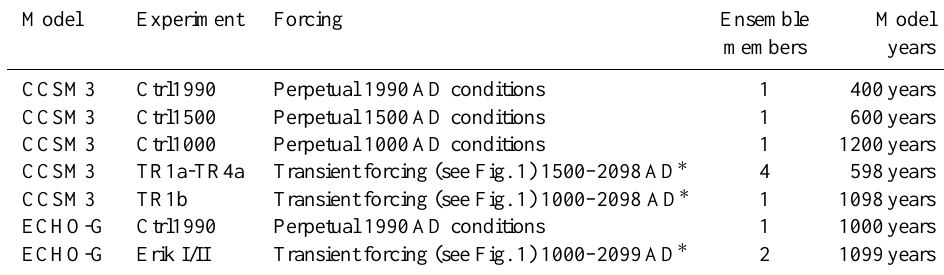
Table 1. Overview of simulations available for the